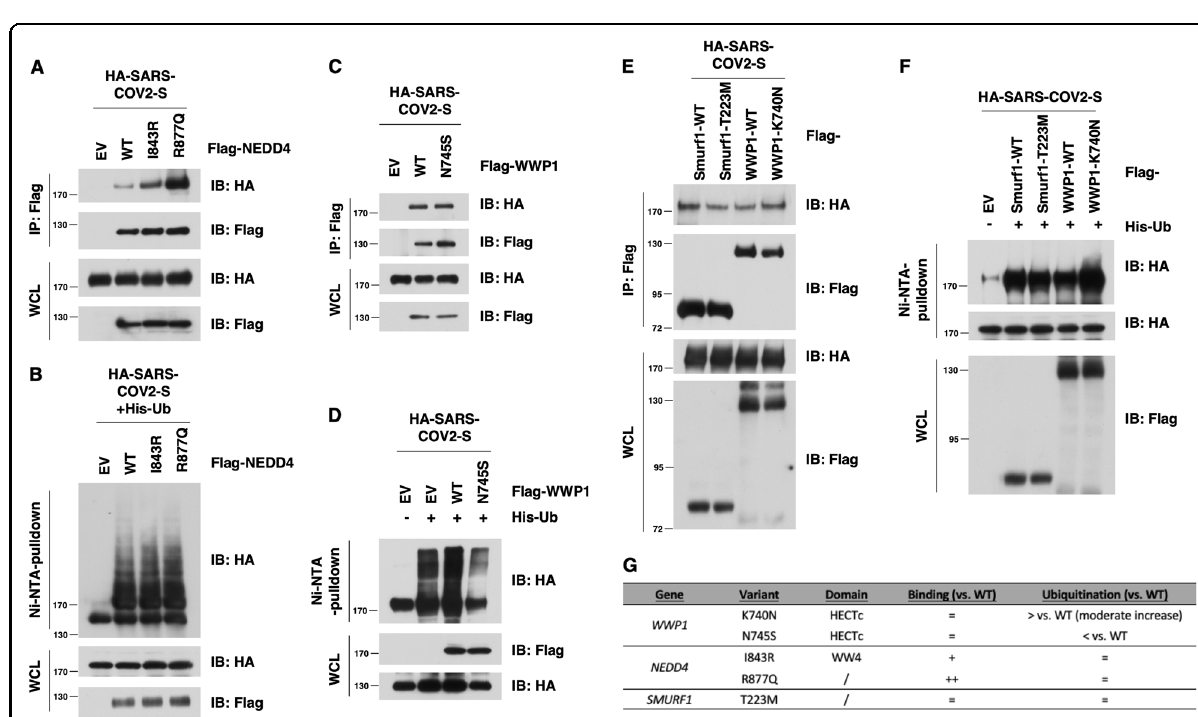
between 50 and 0.069 μ M. The drug was added at dif- ferent time points, before (1 h) and after (1, 24, and 48 h) SARS-Cov-2 multiplicity of infection (MOI = 0.001). CPE